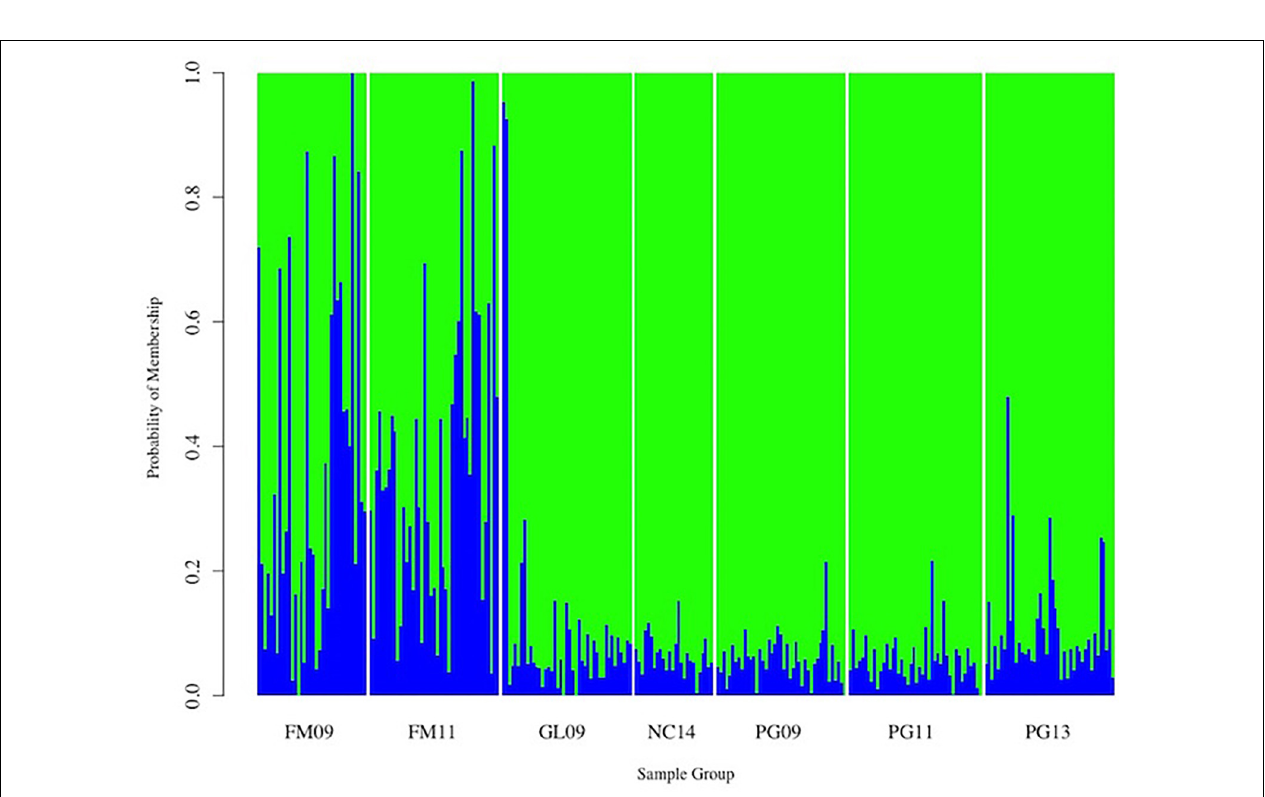
FIGURE 3 | Probability of membership of all sampled individuals to either of two genetic clusters, as recommended by ADMIXTURE.